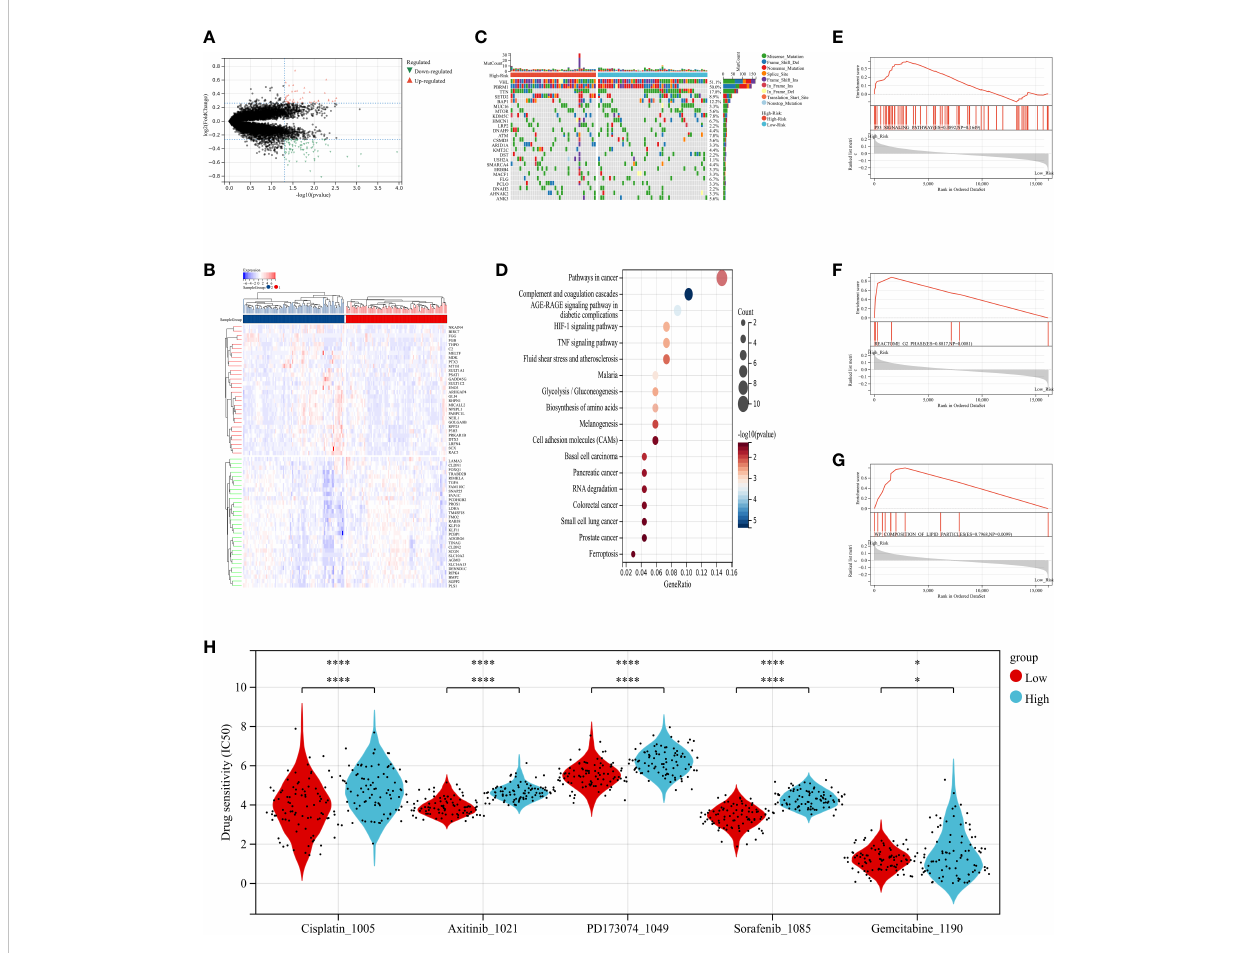
FIGURE 7 The relationship between radiomics and genomics in TCGA. (A) A volcano plot generated using the data of DEGs between high-risk and low-risk groups from TCGA. (B) The waterfall plot of somatic genetic alteration features established with high- and low- radiomics score. (C) Hierarchical clustering of 30 DEGs of RCC. (D) KEGG pathways analysis of DEGs associated with radiomics signature. (E – G) Gene Set Enrichment Analyses showed three representative pathways enriched in the high-radiomics score group. (H) Relationships between radiomics signature and drug